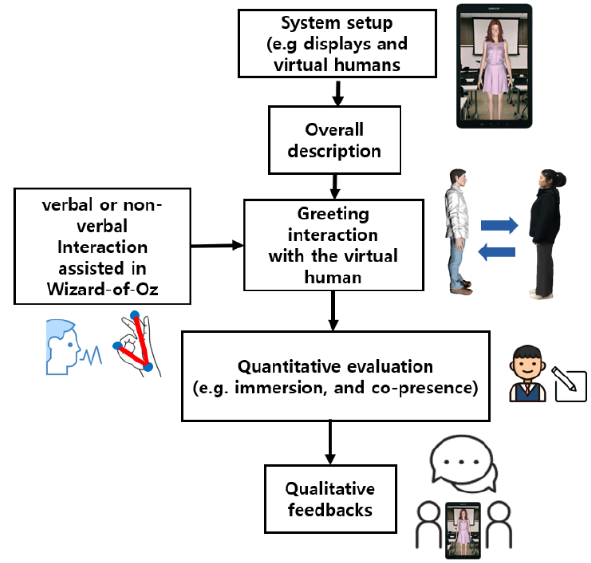
Figure 7. A diagram of our experiment process.